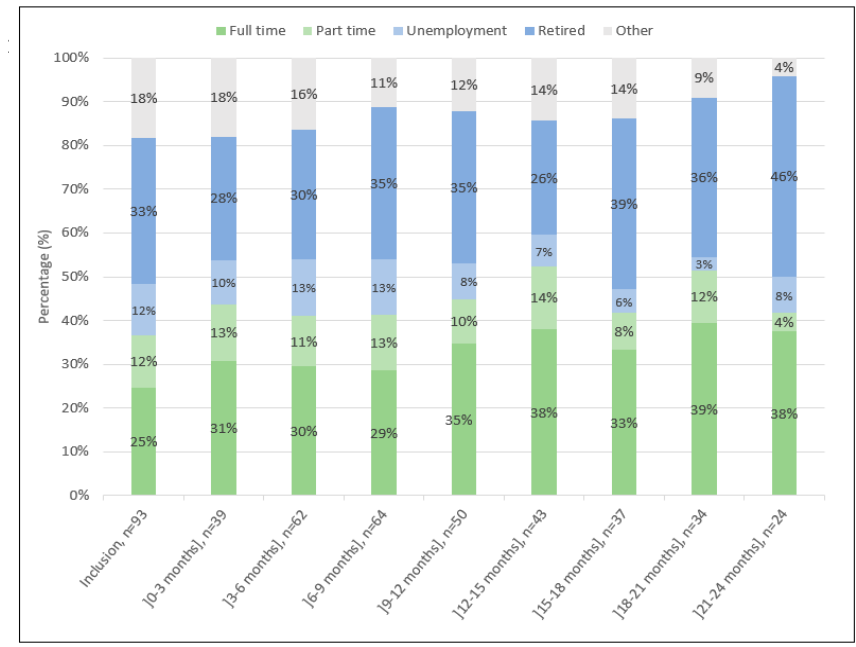
Figure 7. Evolution of the professional situation.